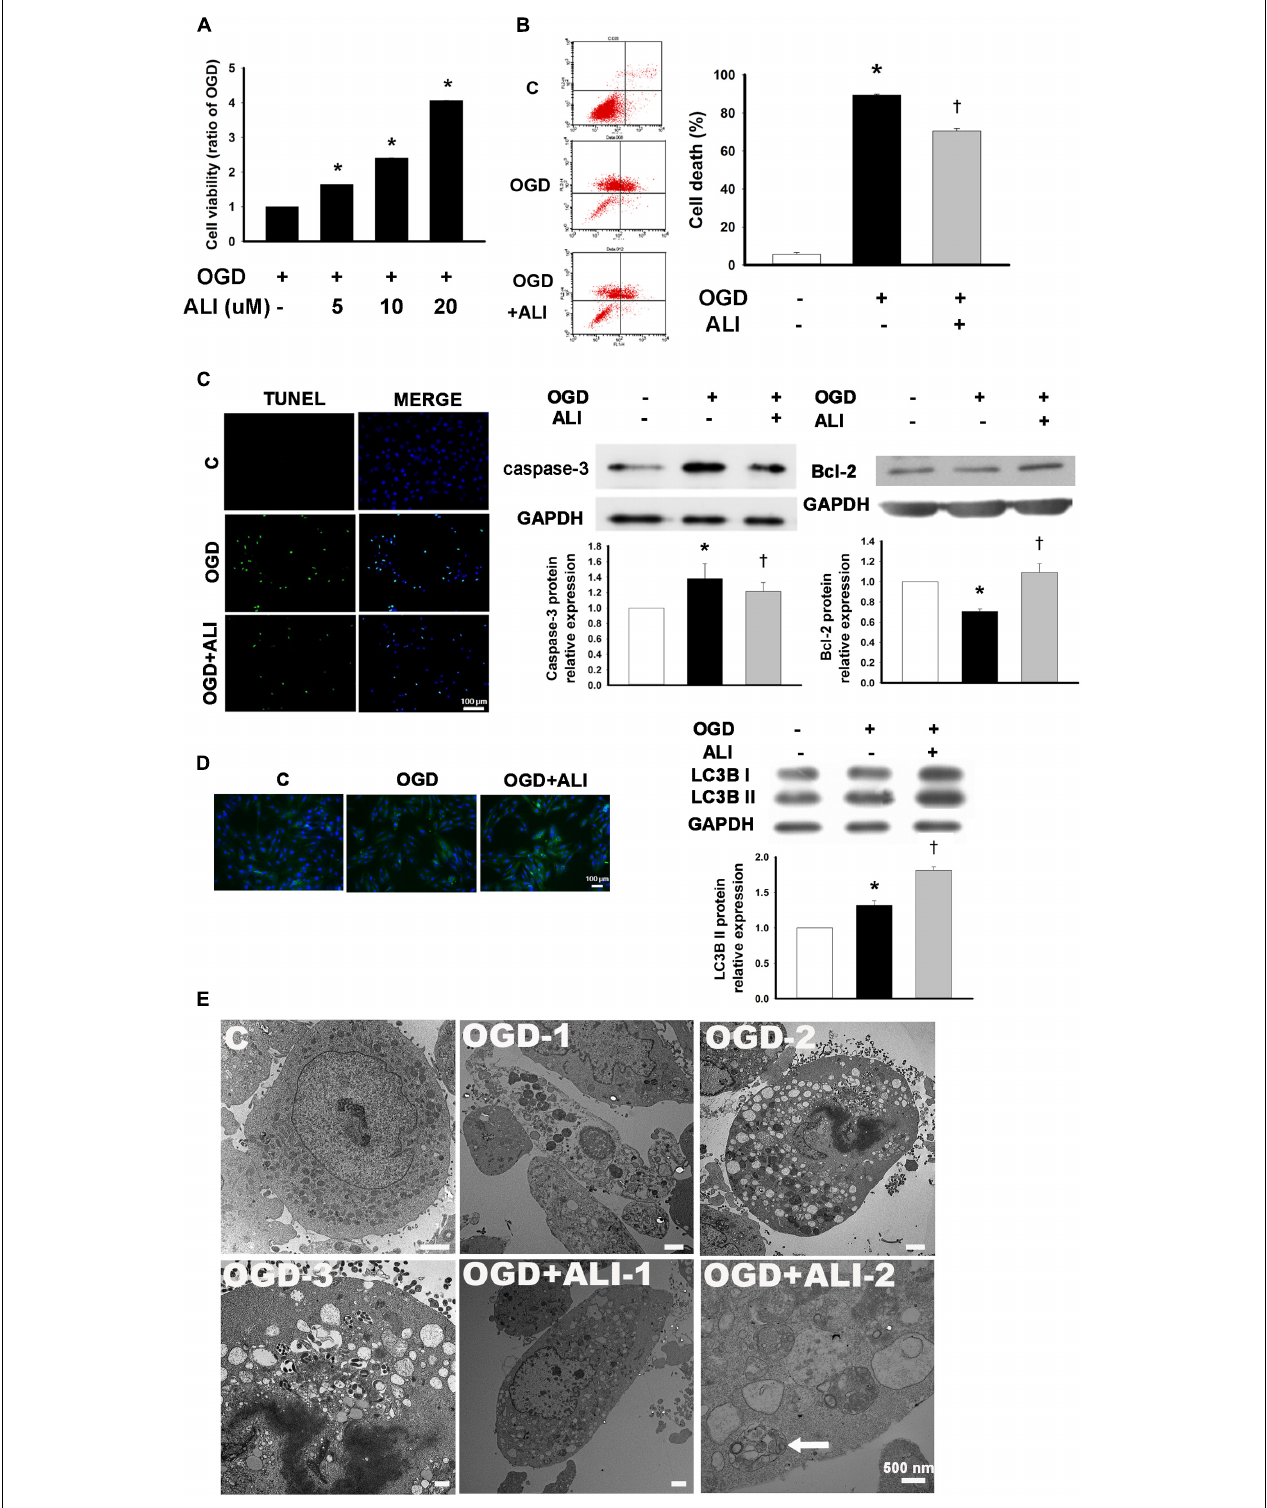
FIGURE 4 | Aliskiren increases cell viability in oxygen glucose deprivation (OGD)-treated H9c2 cells via the upregulation of autophagosome formation. (A) Cardiomyocytes treated with 5, 10, or 20 µ M of aliskiren were exposed to OGD for 16 h, and then cell viability was examined by the MTT assay. ∗ P < 0.05